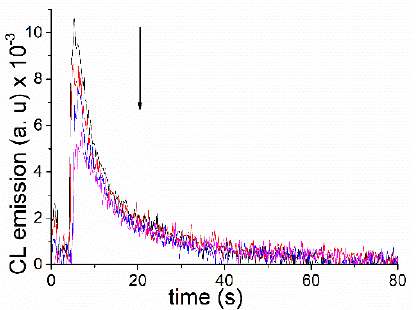
Figure 6. Reduction of luminol’s chemiluminescence (7.5 μ M) in the presence of increasing amounts of ETPP (0 – 7.8 mM) in aqueous solutions at pH